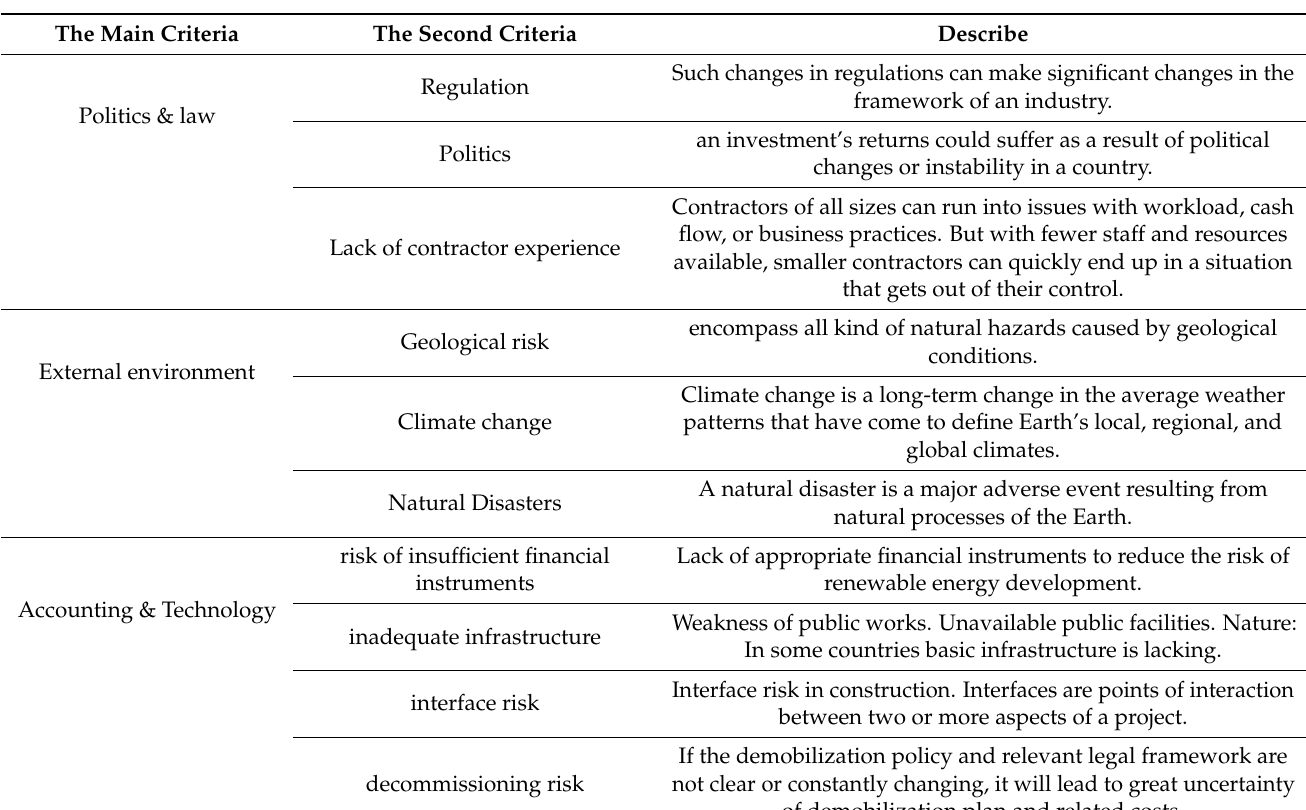
Table A2. The hierarchical framework of risk